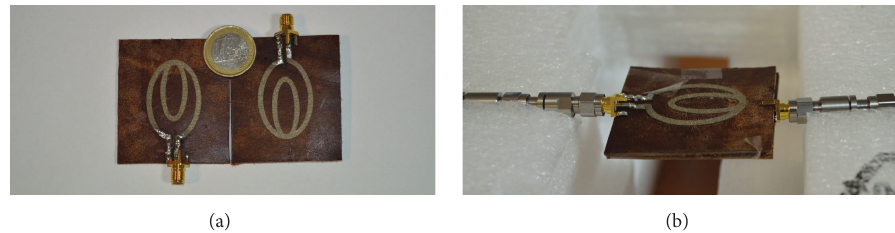
Figure 6: Picture of the fabricated prototype: (a) the two resonators; (b) measurements